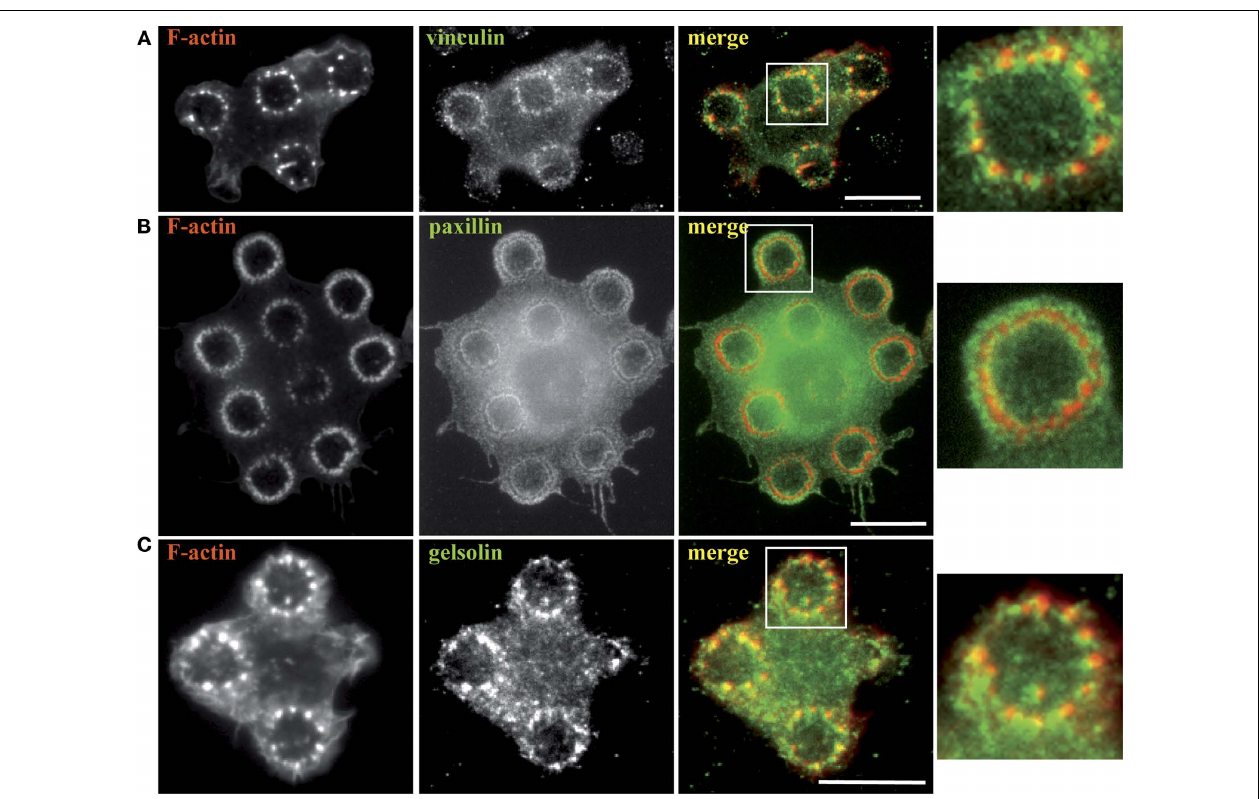
paxillin (B) , and gelsolin (C) . Actin in RAW cells was visualized thanks to GFP fluorescence (A,C) . Zoomed images correspond to the areas indicated by white boxes in the corresponding merged images. Bars = 5 μ m.